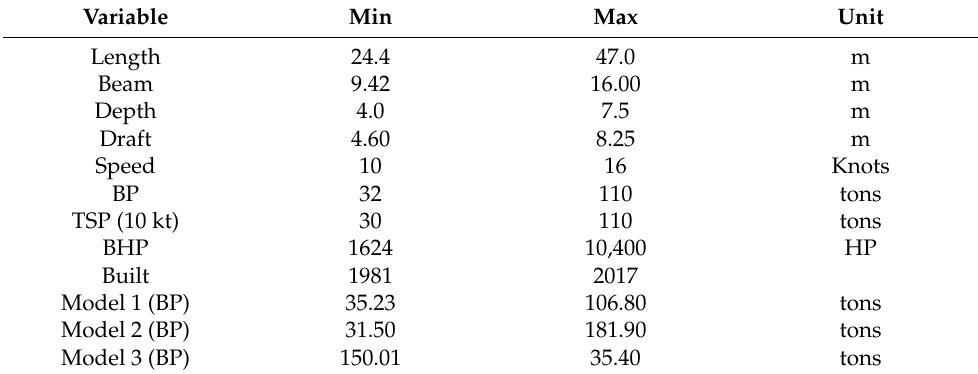
Table 3. Validity range of Models 1, 2, and